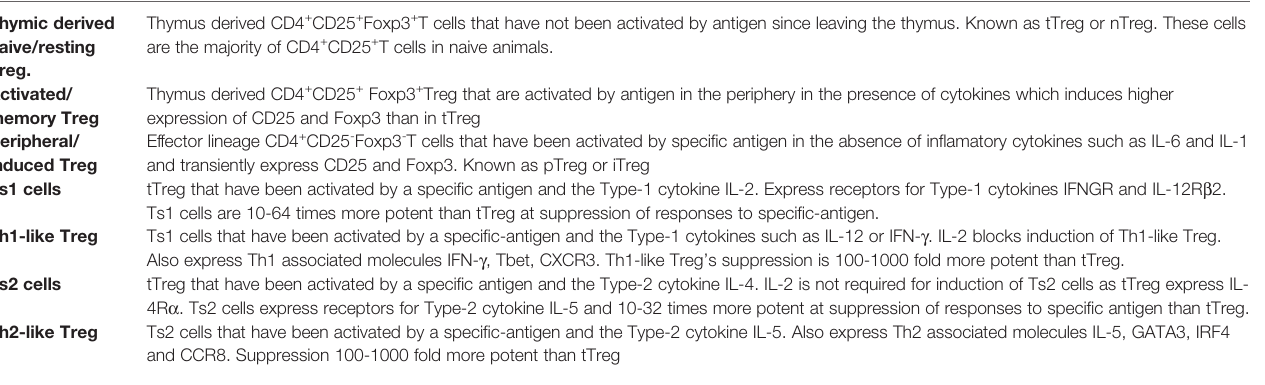
TABLE 1 | De fi nition of subpopulations of cells within peripheral lymphoid CD4 + CD25 + Foxp3 + T cells relevant to this study. Thymic derived naive/resting